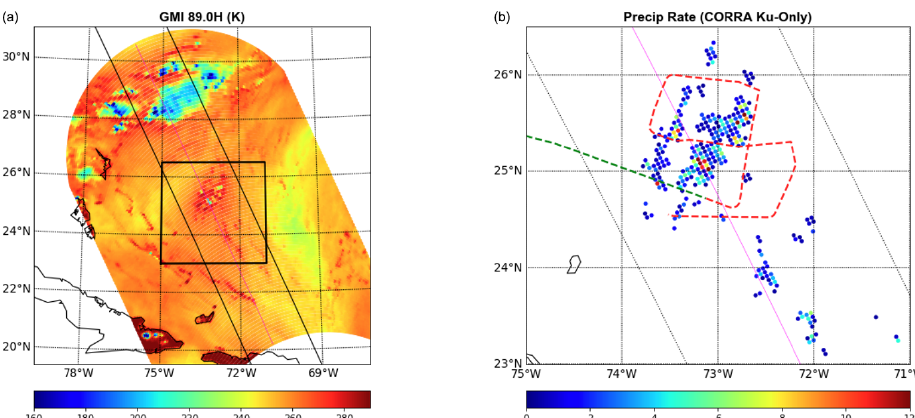
Figure 5. GPM overpass near 18:52UTC on 10 June 2017. (a) GMI 89HGHz channel (Kelvin). (b) Zoom-in of the precipitation rate estimated by CORRA (mmh − 1 ) over the box area shown in (a) . In both panels, the black lines show the swath of the DPR Ku-band radar. In panel (a) , the thin magenta line near the satellite sub-track denotes the DPR cross section shown in Fig. 6. The green and red dashed lines indicate the DC-8 flight tracks between 18:30–19:30 and 19:30–20:30UTC,